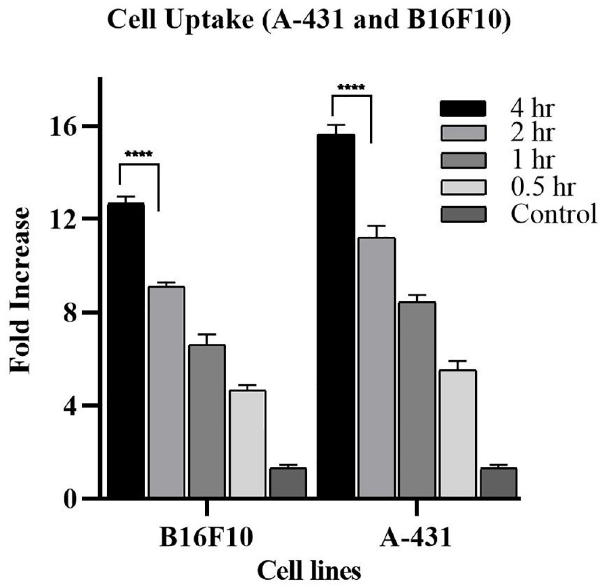
Fig 7. Cell uptake of SLNs as compared to control after 0.5, 1, 2 and 4 hr. All results indicate mean ± SD, n = 3. ���� p < 0.0001 (After Two-way ANOVA with Tukey’s post hoc